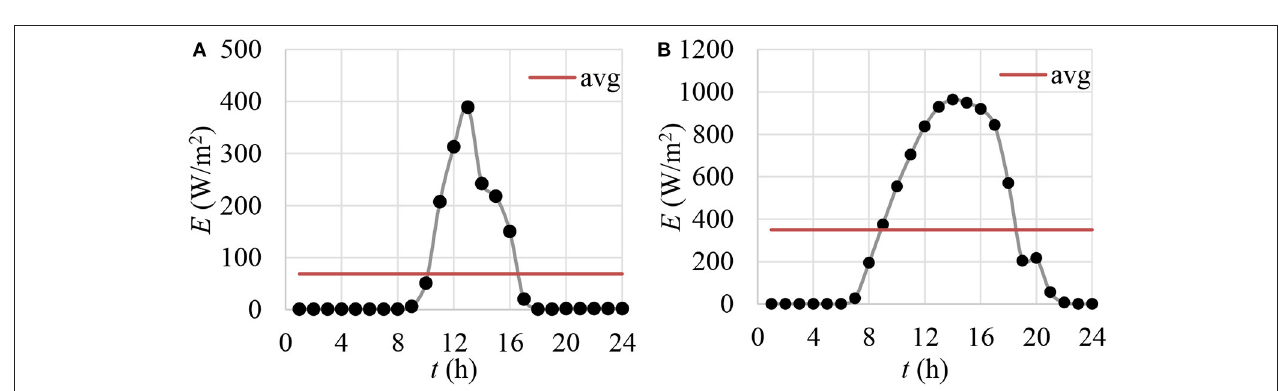
FIGURE 4 | Hourly and average solar irradiation data for (A) winter month (January 2019) and (B) summer month (July 2019).